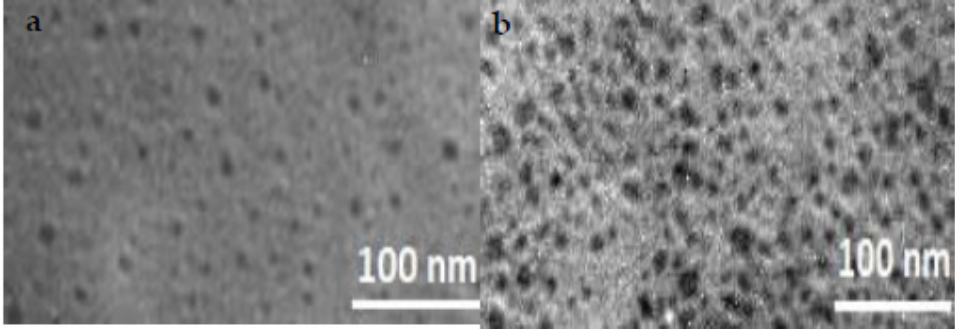
Figure 2. Images of CDs obtained from tunneling electron microscopy from this study. Images show variance in particle and size distributions (at 180 ◦ C and 3 h). ( a ) bottom-up; ( b ) top-down.